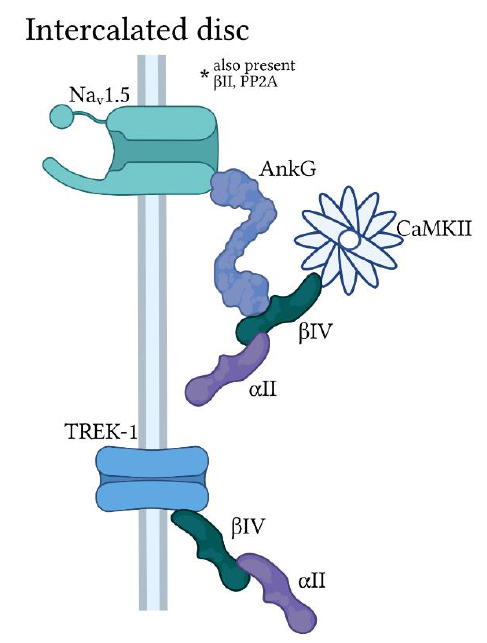
Figure 4. Ankyrin-G/spectrin-based macromolecular complexes at the cardiomyocyte intercalated disc. Ankyrin-G (AnkG) is found primarily at the cardiomyocyte intercalated disc with α II and β IV -spectrin in a macromolecular complex for regulation of the voltage-gated Na + channel Na v 1.5 by Ca 2+ /calmodulin-dependent kinase II (CaMKII). A subpopulation of the protein phosphatase PP2A is also targeted by AnkG/spectrin for modulation of Na v 1.5 activity (not pictured). β IV -spectrin also associates with the two-pore domain K + channel TREK-1 at the intercalated disc in an AnkG-independent manner.